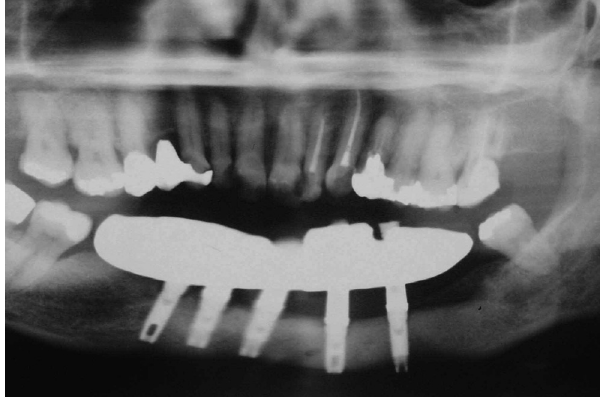
Figure 10 - Panoramic radiograph taken after 10 years of follow-up showing absence of lesion